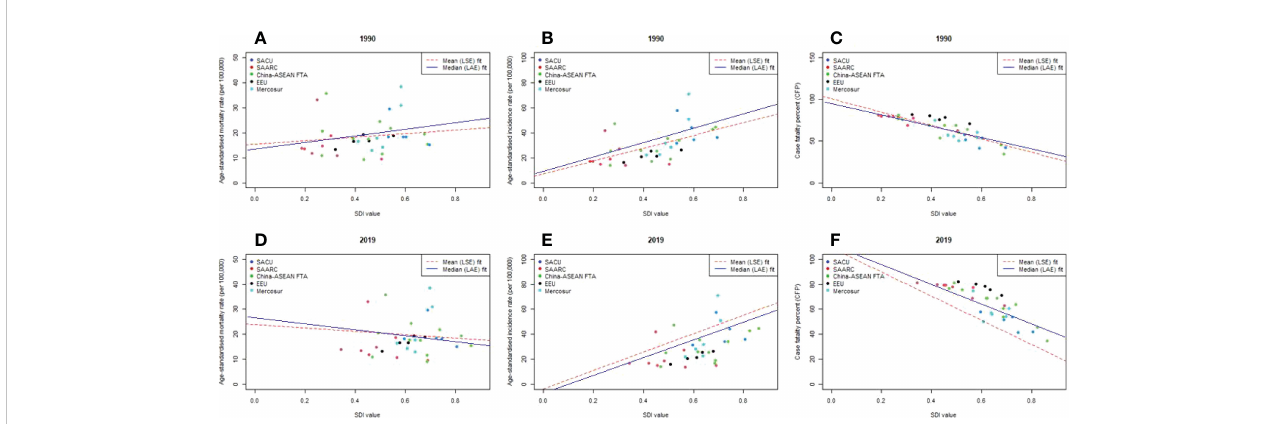
FIGURE 6 Country wise correlation between age-standardised BC rate and country ’ s sociodemographic index (SDI) across BRICS-Plus; (A) mortality rate in 1990 (B) incidence rate in 1990 (C) Case fatality percent (CFP) in 1990; (D) mortality rate in 2019 (E) incidence rate in 2019 (F) Case fatality percent (CFP) in 2019; Case-fatality percent was calculated by dividing age-standardised death rate by age-standardised incidence rate and multiplied by 100; LSE, Least Square Error fi t; LAE, Least Absolute Error fi t; SDI ranges from 0 (less developed) to 1 (most